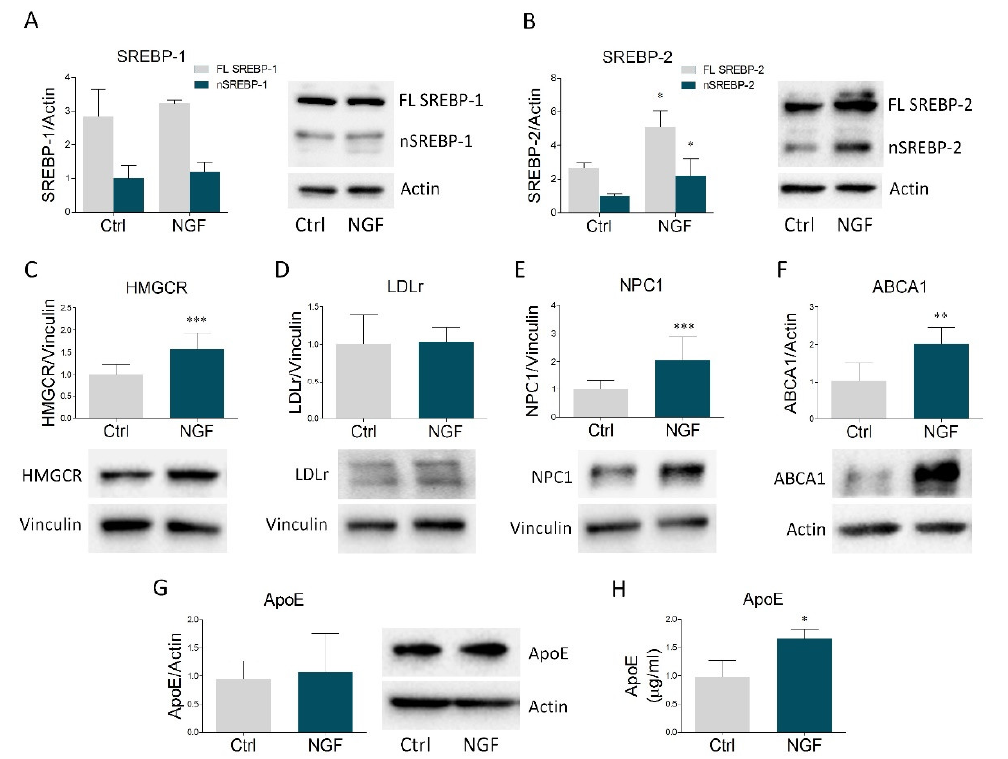
Figure 1. NGF modulates the expression of the main proteins involved in cholesterol homeostasis in U373 cells and enhances ApoE secretion in U373 culture medium. ( A – G ) Representative Western blot and densitometric analysis of SREBP-1, SREBP-2, HMGCR, LDLr, NPC1, ABCA1, and ApoE in U373 cells treated with vehicle (Ctrl) and NGF (100 ng/mL) for 48 h. n = 6 different experiments. Actin and vinculin were used as loading controls. ( H ) Quantification of ApoE levels (µg/mL) by ELISA assay in vehicle- and NGF-treated U373 culture medium. n = 3 different experiments. Data represent means ± SD. Statistical analysis was assessed by using unpaired Student’s t test. * p < 0.05, ** p < 0.01, *** p < 0.001.